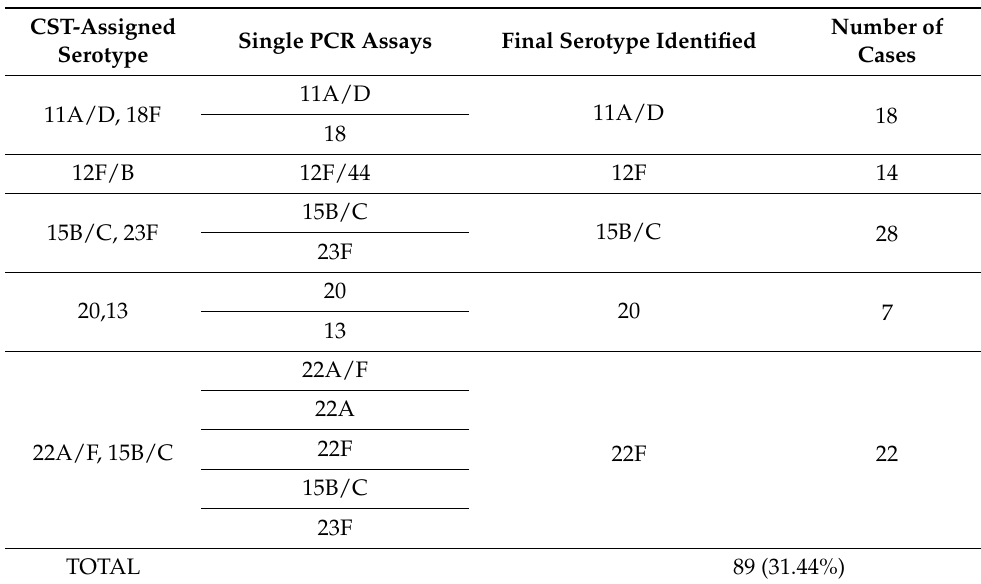
Table 4. Pneumococcal serotype identification by the application of CST in combination with specific single-tube PCR assays.